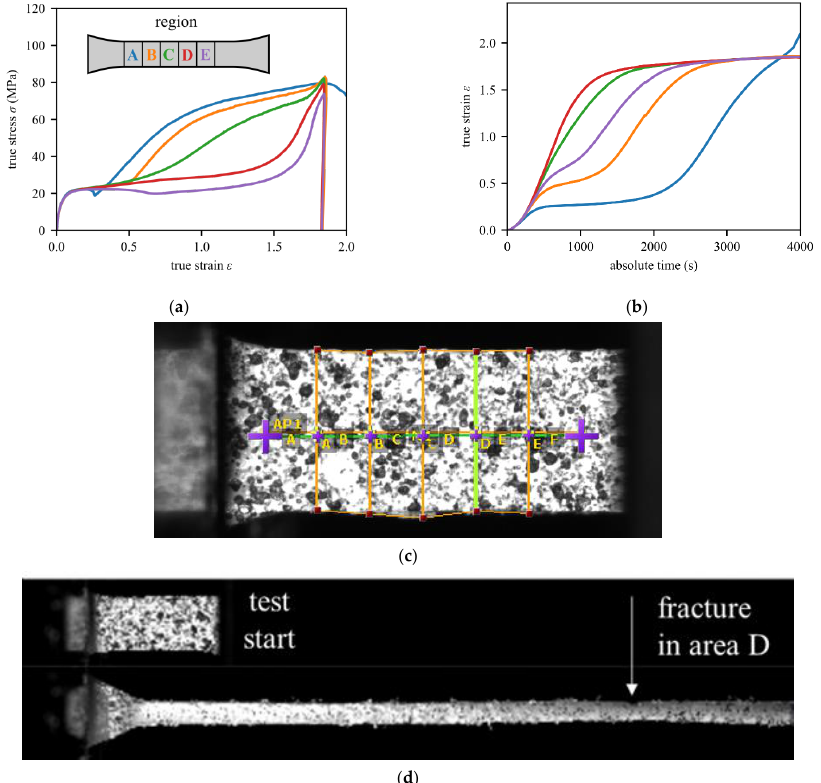
Figure 4. Results of the tensile test with a white specimen with true stress and strain computed using the DIC measurements. Plotted are ( a ) the stress – strain curve and ( b ) the strain – time curve to identify regions that reach high strains earlier. In ( c ), the actual speckle pattern and used evaluation regions are shown. Sub-figure ( d ) shows the front view of a tested sample at the test start and the final frame before failure, including the point of fracture onset in area D.